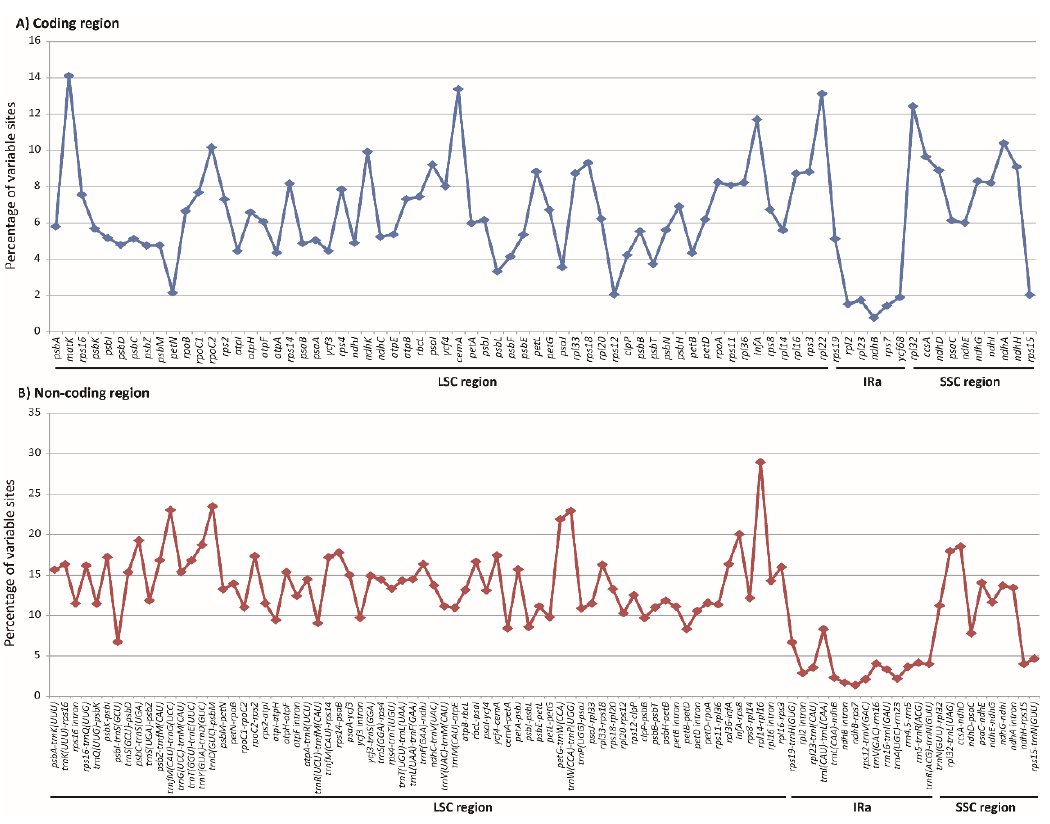
Figure 5. Percentage of variable characters (Single Nucleotide Polymorphisms, SNPs) in homologous loci among chloroplast genomes of Olyreae. ( A ) Coding region. ( B ) Non ‐ coding region. The homologous loci are ordered according to their locations in the chloroplast genome.